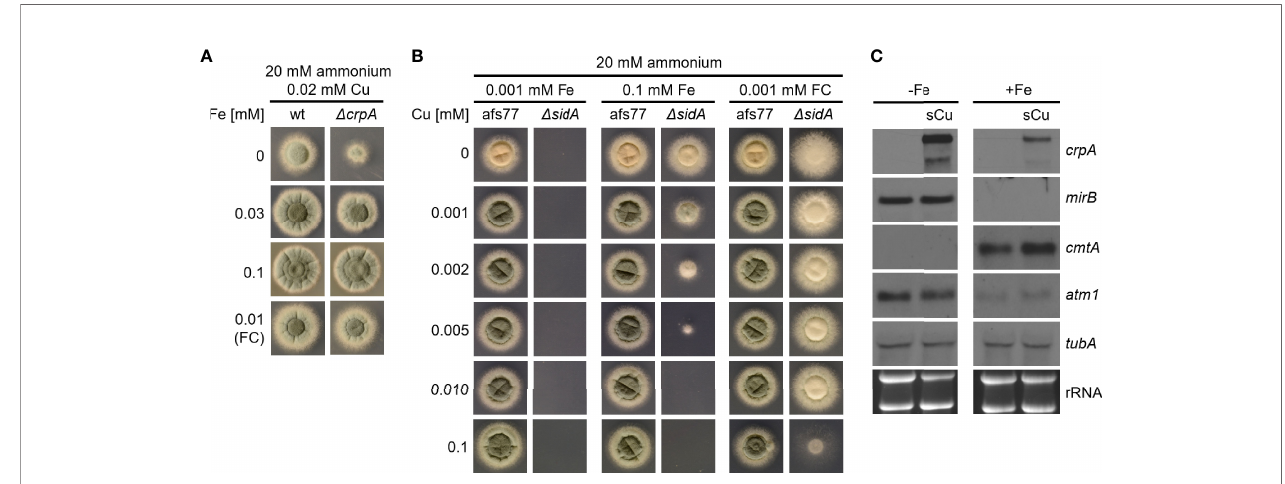
FIGURE 7 | Fe availability impacts Cu resistance. (A) A. fumigatus conidia were point-inoculated on AMM plates with 20 mM ammonium as nitrogen source and 0.02 mM Cu combined with different concentrations of Fe or ferricrocin (FC)-chelated Fe. (B) A. fumigatus conidia were point-inoculated on AMM plates with 20 mM ammonium as nitrogen source with different concentrations of Fe or FC-chelated Fe combined with different concentrations of Cu. Afs77 is the genetic background of the D sidA mutant strain (Schrettl et al., 2004). (C) A. fumigatus wt was grown for 16 h at 37°C in AMM liquid cultures with ammonium as nitrogen source and 0.005 mM Cu without (-Fe; Fe limitation) or with (+Fe, Fe suf fi ciency) 0.03 mM Fe, respectively. Subsequently, the mycelia were harvested or incubated for another 45 min after addition of Cu to a fi nal concentration of 0.2 mM (sCu). After harvesting the mycelia, total RNA was isolated and subject to Northern analysis of the indicated genes. Siderophore transporter encoding mirB was used as control for cellular Fe starvation (Schrettl et al., 2010). Ethidium bromide-stained rRNA and a - tubulin encoding tubA served as controls for loading and quality of